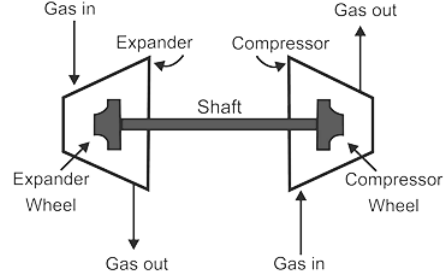
Figure 1. Basic diagram of a turbo expander.